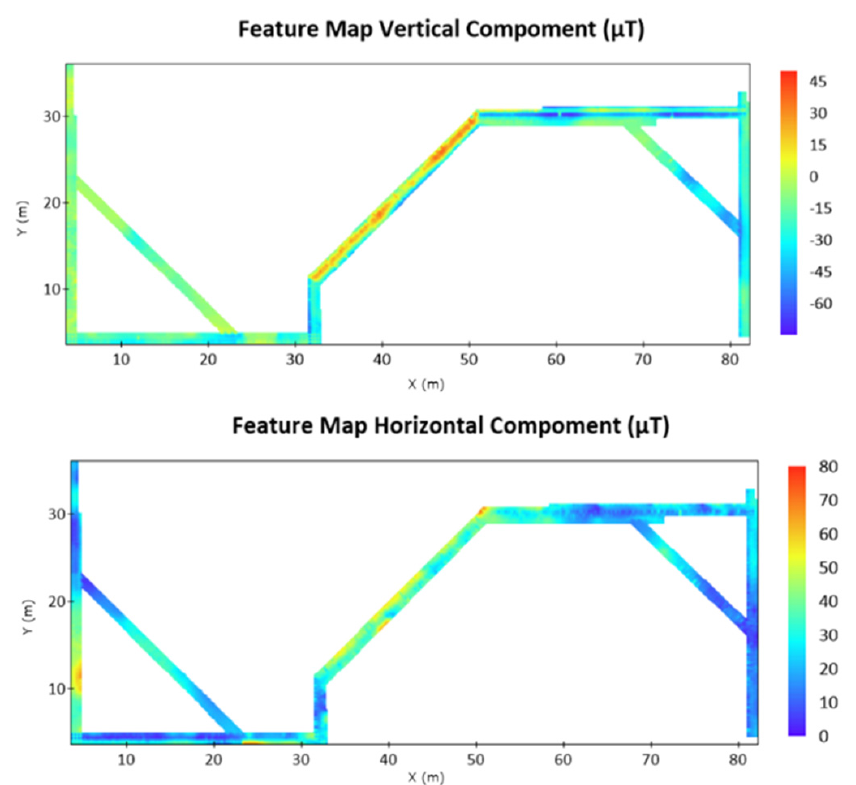
Figure 5. Results related to the collected magnetic field (after interpolation).